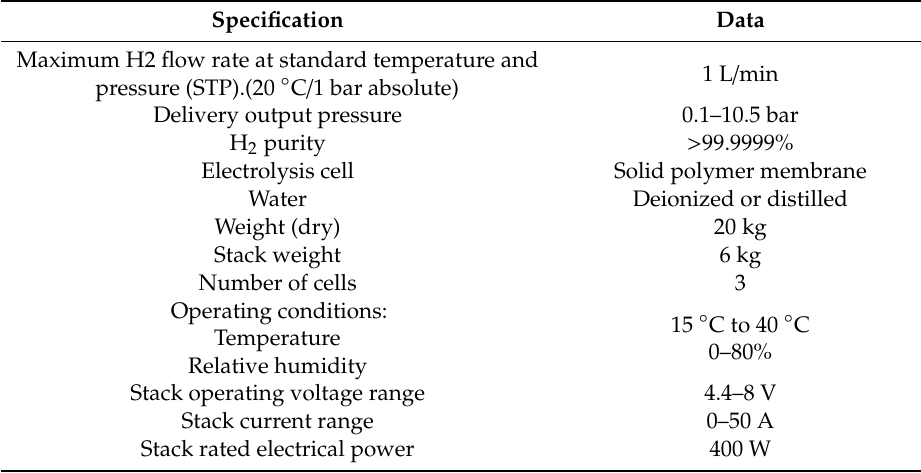
Table 2. Specifications of the proton exchange membrane electrolyzer (PEM-EL) [30]. Specification